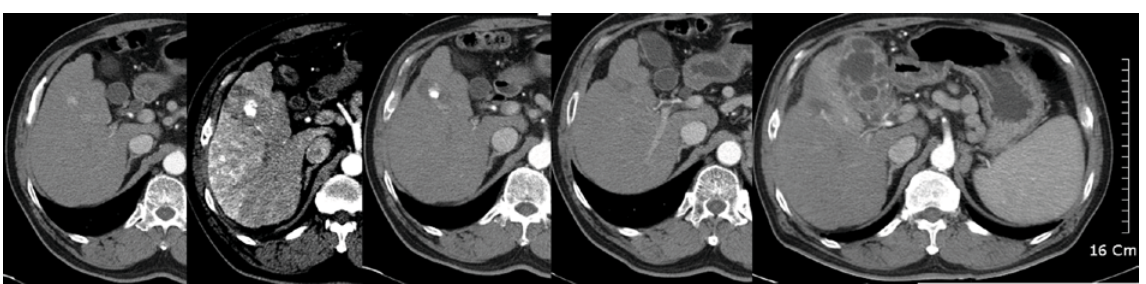
Figure 2. Serial follow-up computed tomography of hepatocellular carcinoma during a period of 14 months. The second image showed a well- defined necrotic low-attenuation lesion in segment 5 with high lipiodol density, indicating successful postablation with satisfactory uptake of lipiodol chemoembolization. From the third to the fifth images, a focal hypodense lesion in the segment 5 of the liver is seen, with overlying capsular retraction and lipiodol wash-out. The fifth image also showed gallbladder-wall thickening due to cholecystitis.